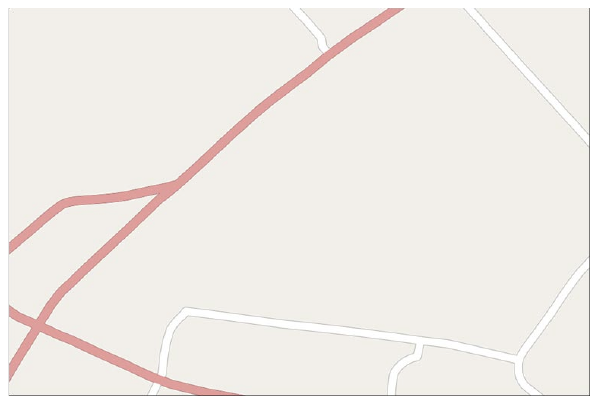
Figure 1. Ushahidi platform plotting Haitian reports on a map